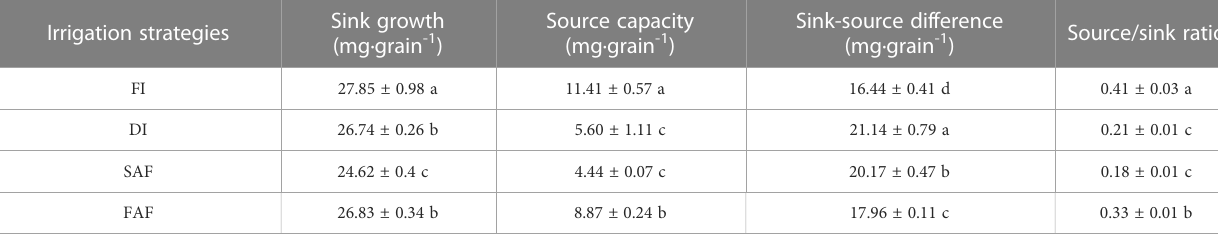
Irrigation strategies